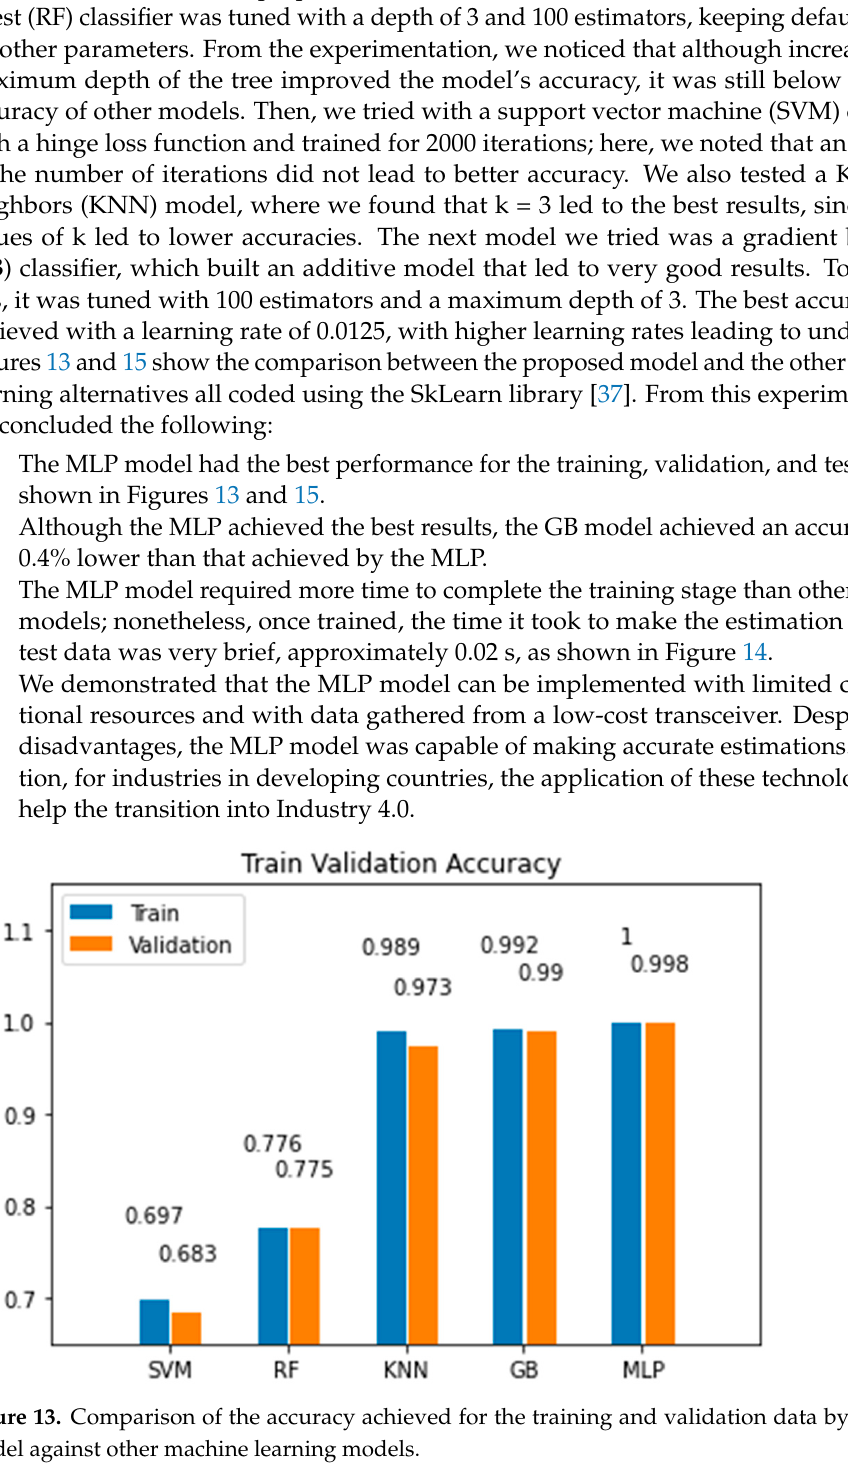
Figure 14. Comparison of the accuracy achieved for the test data by the MLP model against other machine learning models.